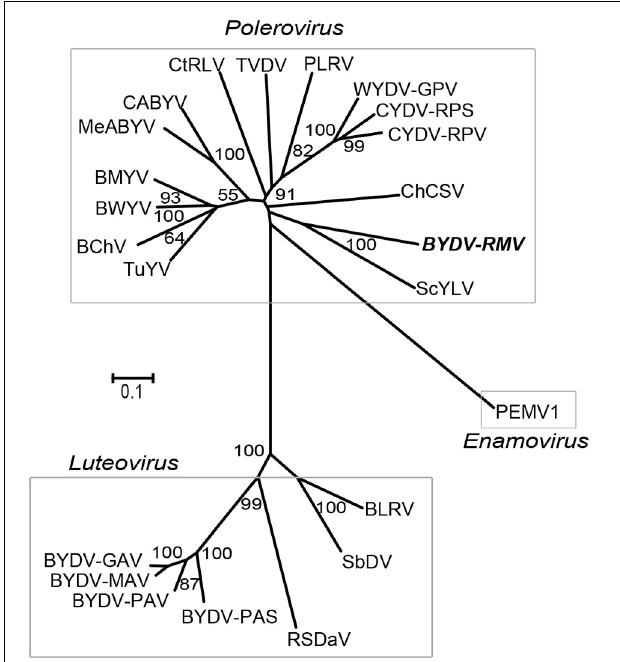
FIGURE 2 | Neighbor-joining tree of Clustal W-aligned whole genome sequences of luteovirids generated in the MEGA 4 software package. Numbers representing bootstrap values when greater than 50% for 1000 replicates are shown.